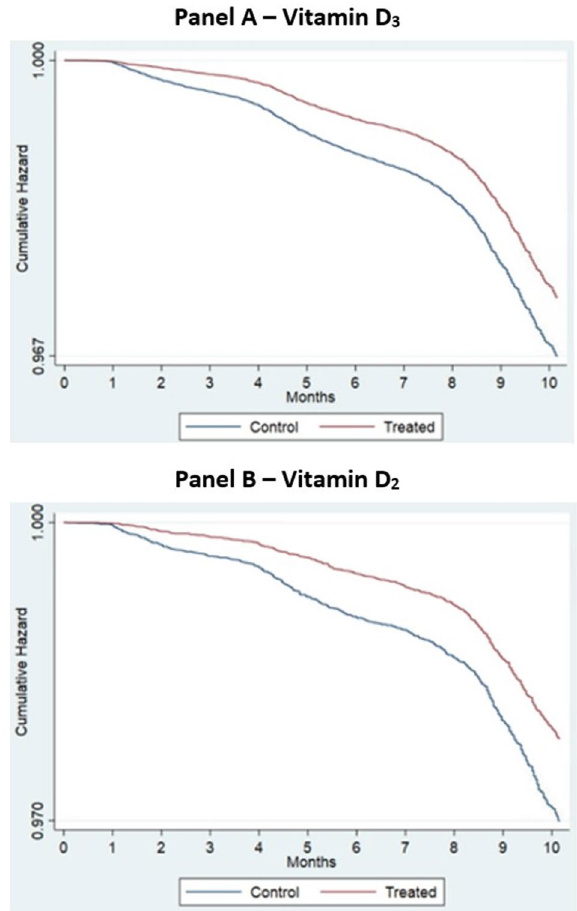
Figure 1. Kaplan Meier curves for vitamin D 3 and D 2 supplement patients versus control—time-to COVID-19